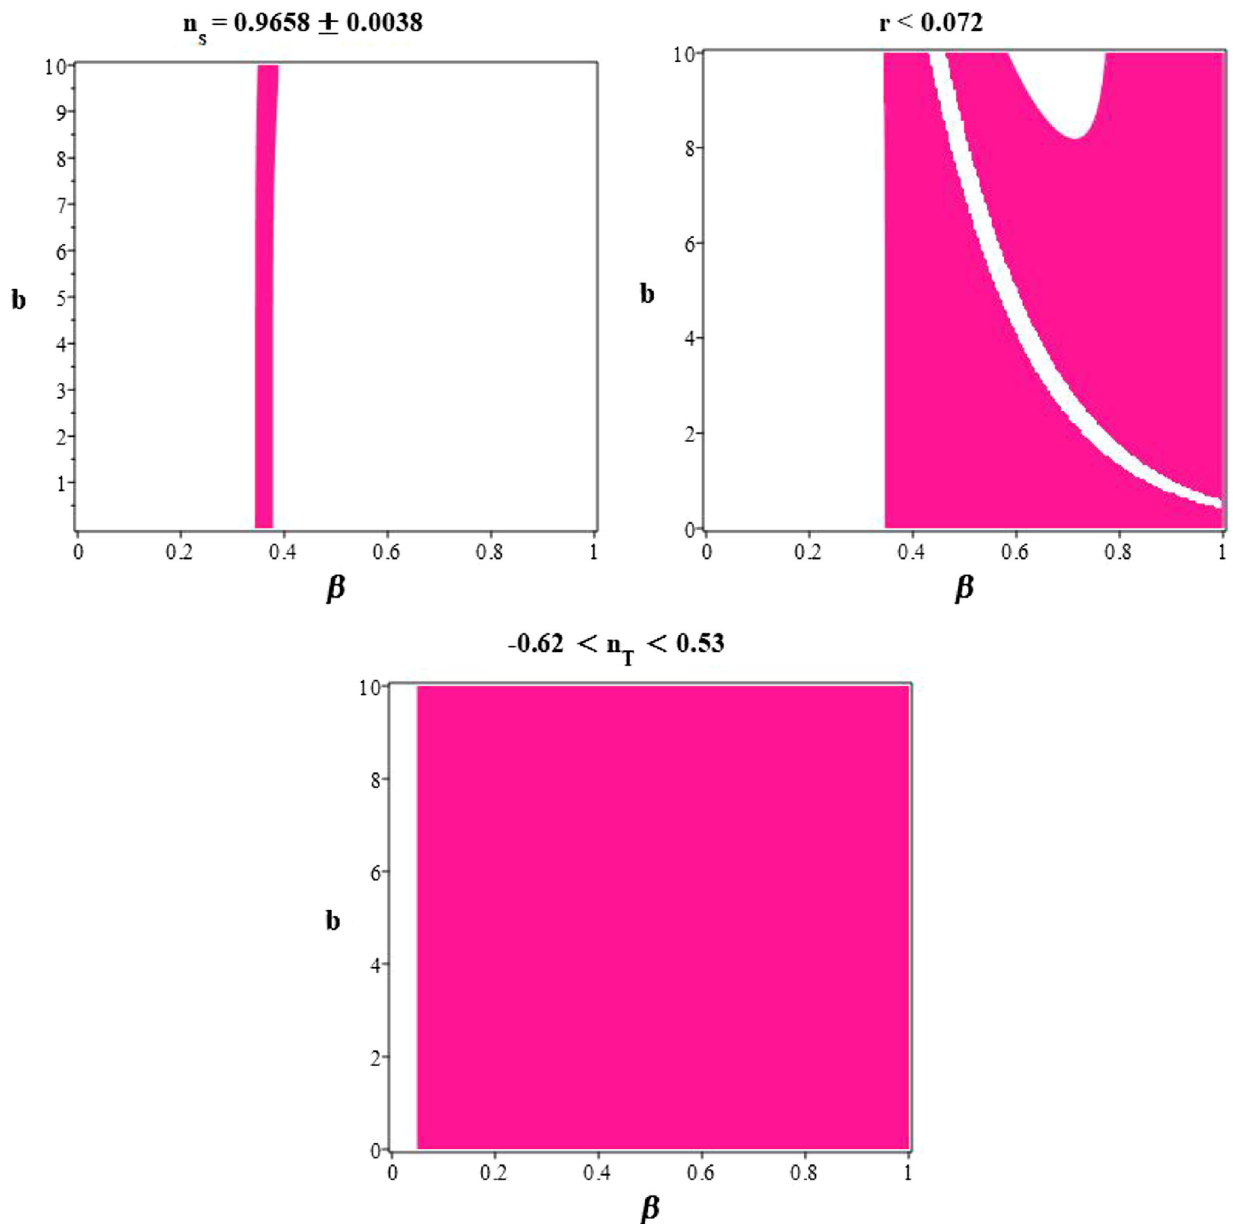
Fig. 5 The upper panels show the ranges of the model’s parameter space that lead to the observationally viable values of the scalar spectral index (the left one) and tensor-to-scalar ratio (the right one), obtained from Planck2018 TT, TE, EE + lowE + lensing + BAO + BK14 data. The lower panel shows the range of the model’s parameter space that